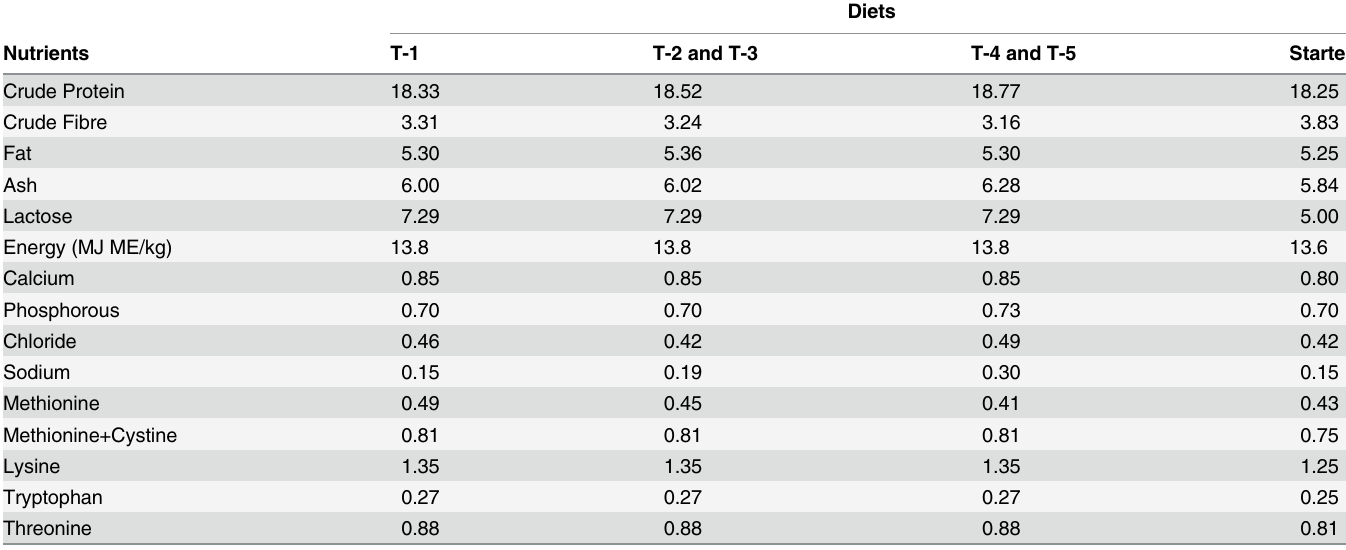
Table 3. Calculated nutrient content of the diets used in Experiment 2, as fed basis.